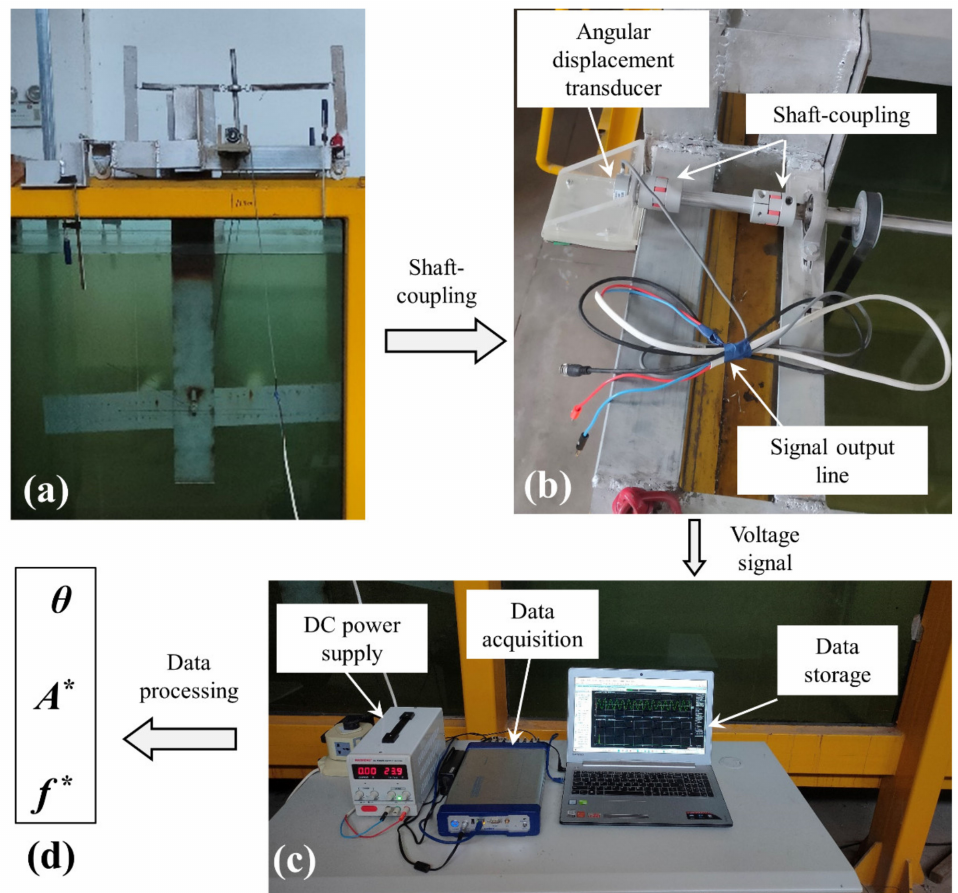
Figure 8. Investigation process of flow-induced rotation: ( a ) The FIR system; ( b ) Angular displace- ment transducer; ( c ) Data acquisition and processing system; ( d ) Experimental